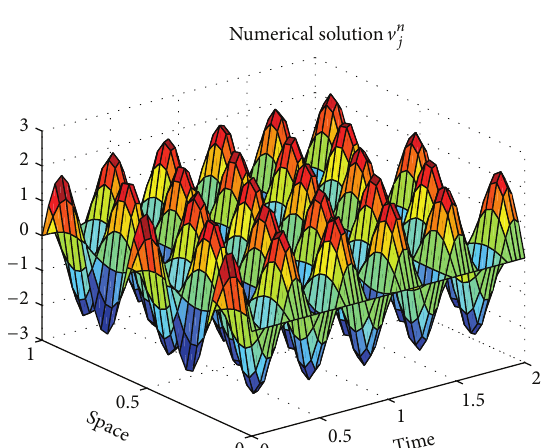
Figure 17: Partial damping.